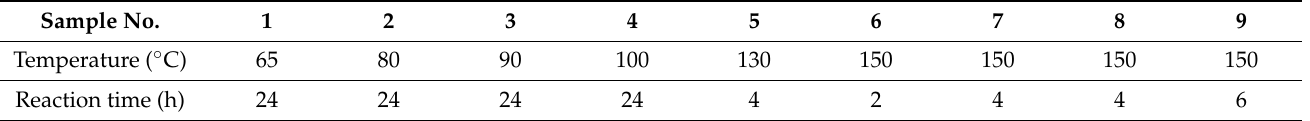
Table 2. The reaction conditions used for SAAP